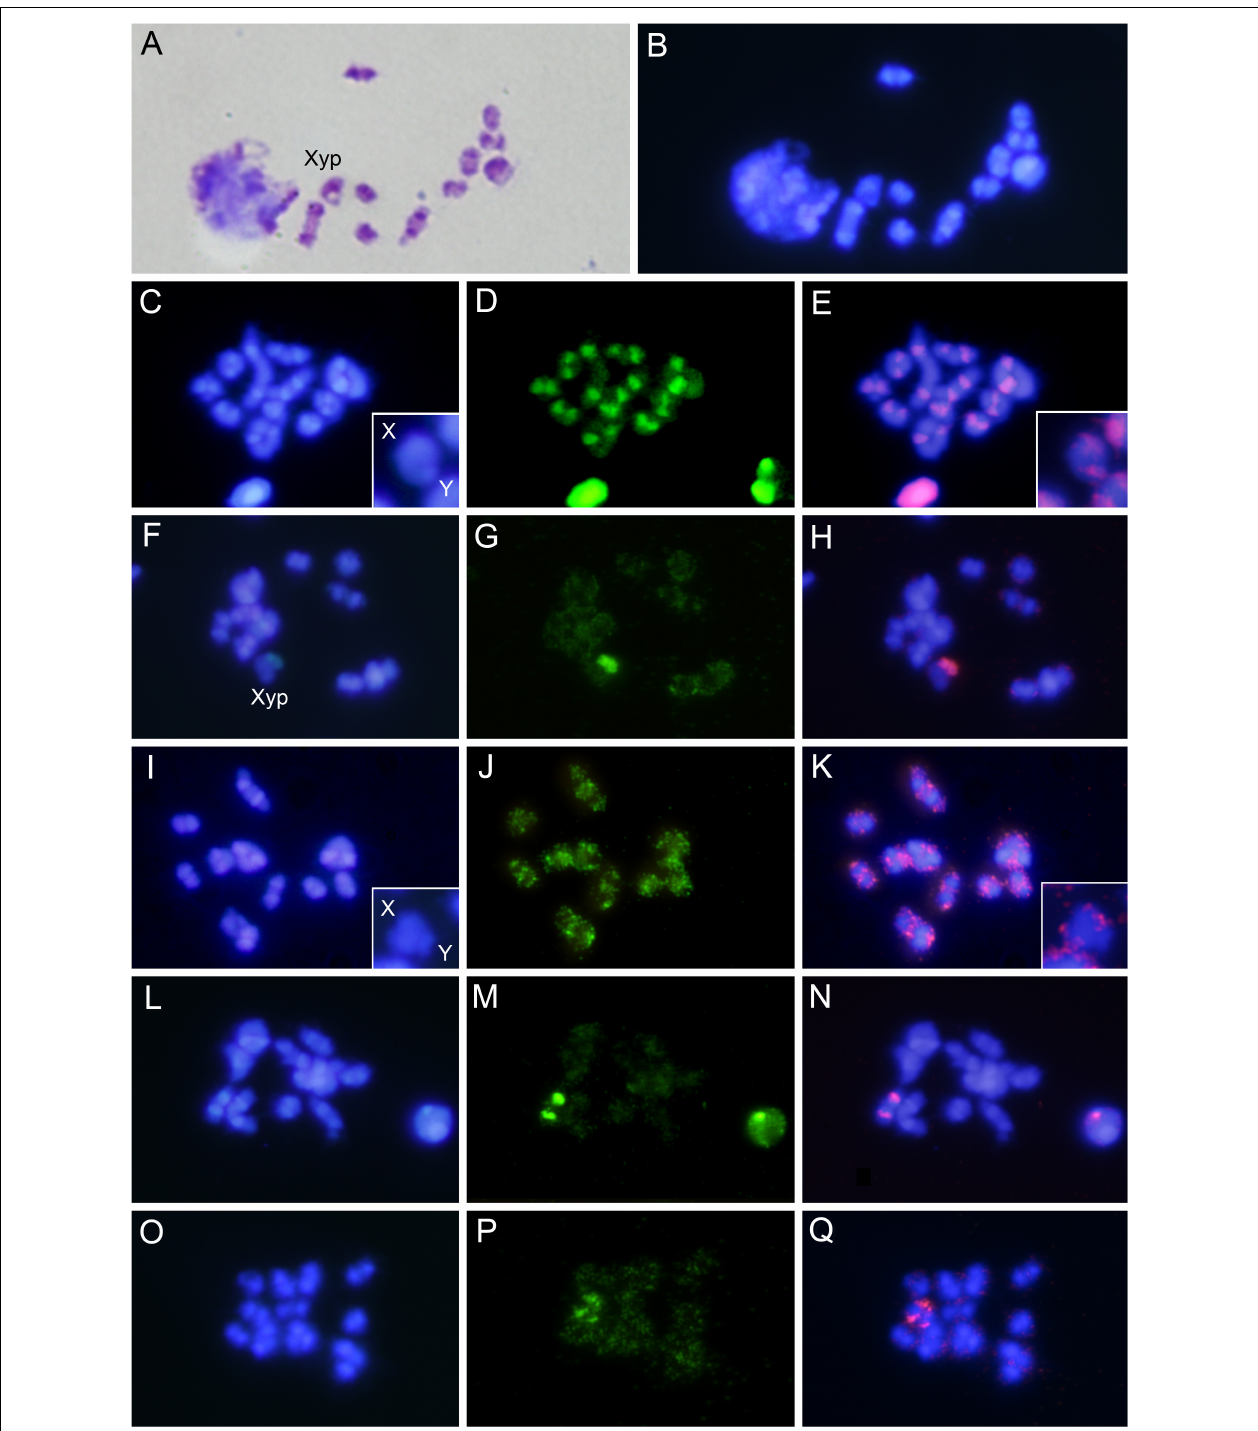
FIGURE 1 | (A) Meiotic cell of Rhynchophorus ferrugineus after C-banding and stained with Giemsa. (B) The same cell after DAPI staining. (C) Meiotic cell after DAPI staining, (D) the same after FISH using RferSat01-169 as a probe, and (E) merged image. (F) Meiotic cell after DAPI staining, (G) the same after FISH using RferSat02-328 as a probe, and (H) merged image. (I) Meiotic cell after DAPI staining, (J) the same after FISH using RferSat03-127 as a probe, and (K) merged image. (L) Meiotic cell after DAPI staining, (M) the same after FISH using RferSat04-53 as a probe, and (N) merged image. (O) Meiotic cell after DAPI staining, (P) the same after FISH using RferSat05-828 as a probe, and (Q) merged image. For RferSat01-169 and RferSat03-127 satDNAs families selected sexual bivalents from other cells are also shown.